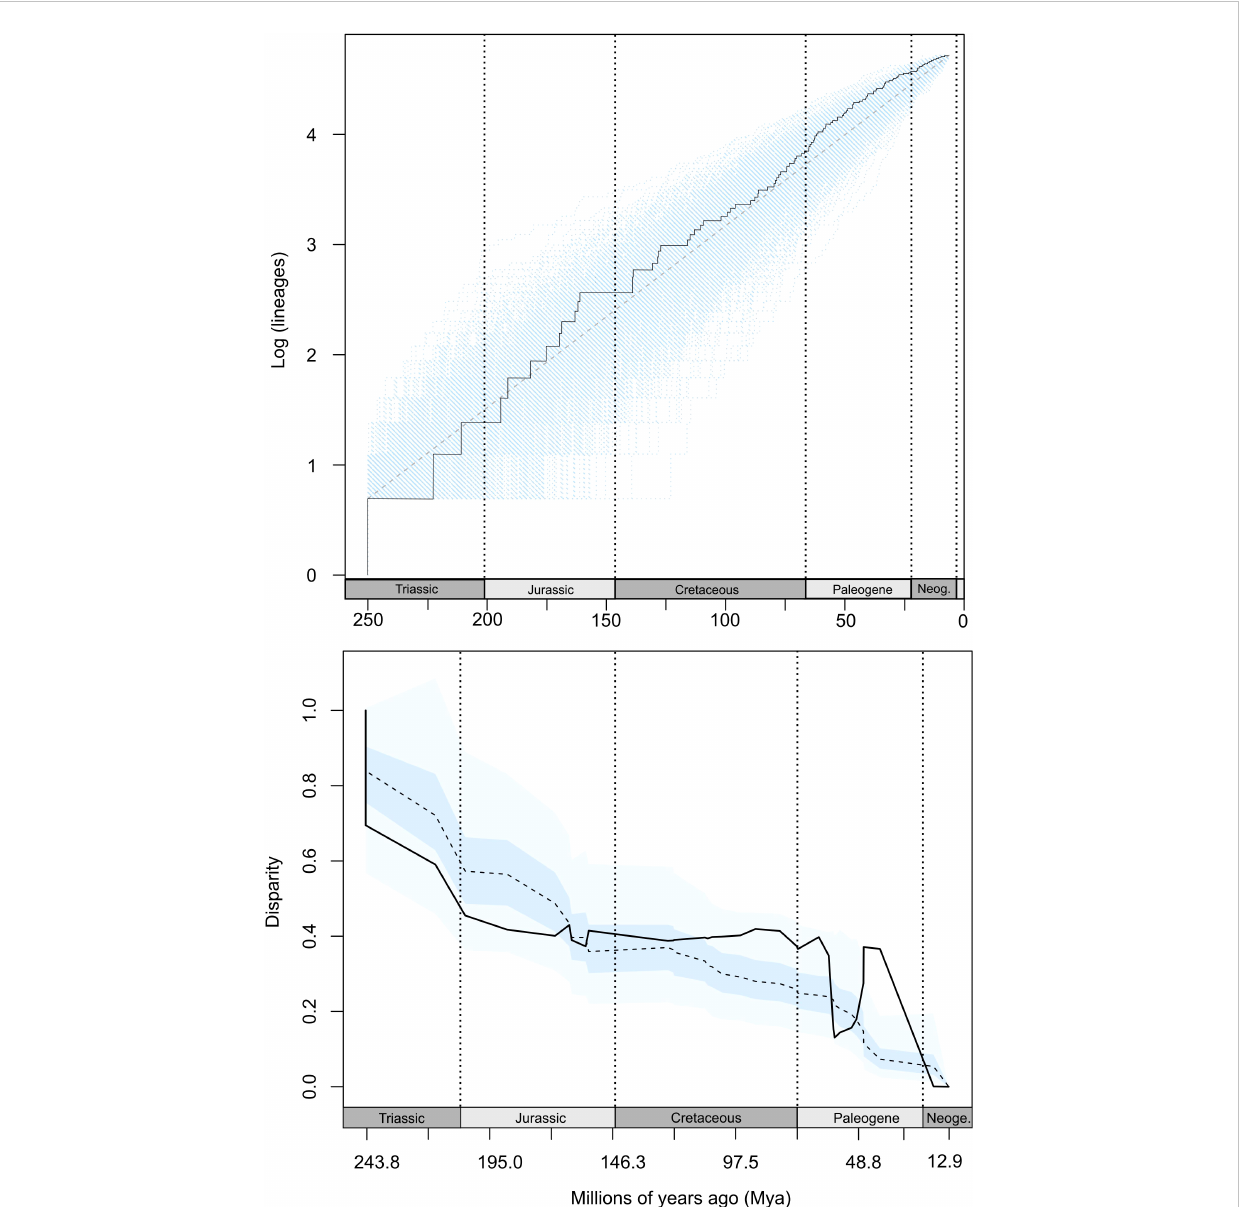
FIGURE 4 Top: Lineage-through time (LTT) accumulation curve for Achelata clade (solid line), from 112 species. Sky-blue-coloured area represents con fi dence interval estimated from 1000 simulated trees under the pure-birth null model. Diagonal dashed line designates the mean value from simulations. Bottom: Disparity-through-time (DTT) for shape (solid line). Coloured areas represent con fi dence intervals estimated from simulations under BM. Dashed line is the median disparity from simulations. Vertical dotted lines indicate divisions between geological